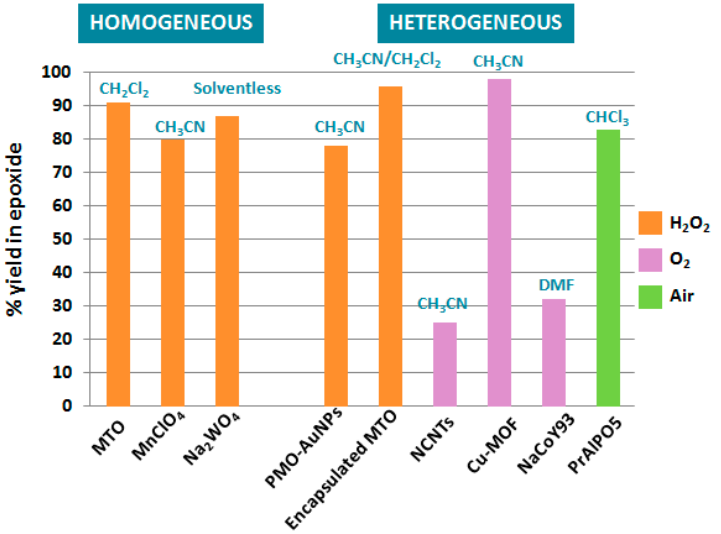
Figure 8. Overview of catalytic systems for epoxidation of α -pinene.